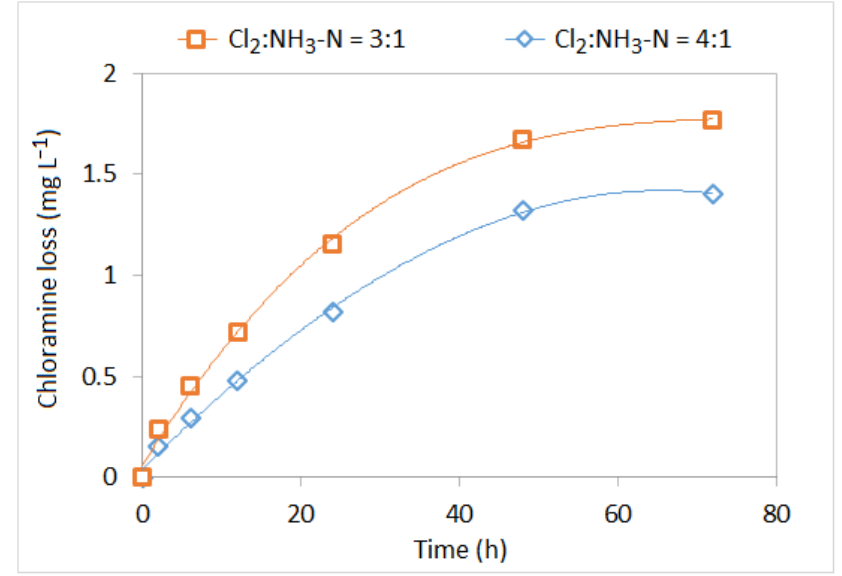
Figure 4. Chloramine decay at chlorine-to-ammonia ratios of 3:1 and 4:1 with initial chloramine concentration = 3 mg L −1 , TOC = 2.6 mg L −1 , pH = 7.0, and T= 25 °C (based in part on Zhou et al. [134], Water Environment Research © 2013 Wiley).